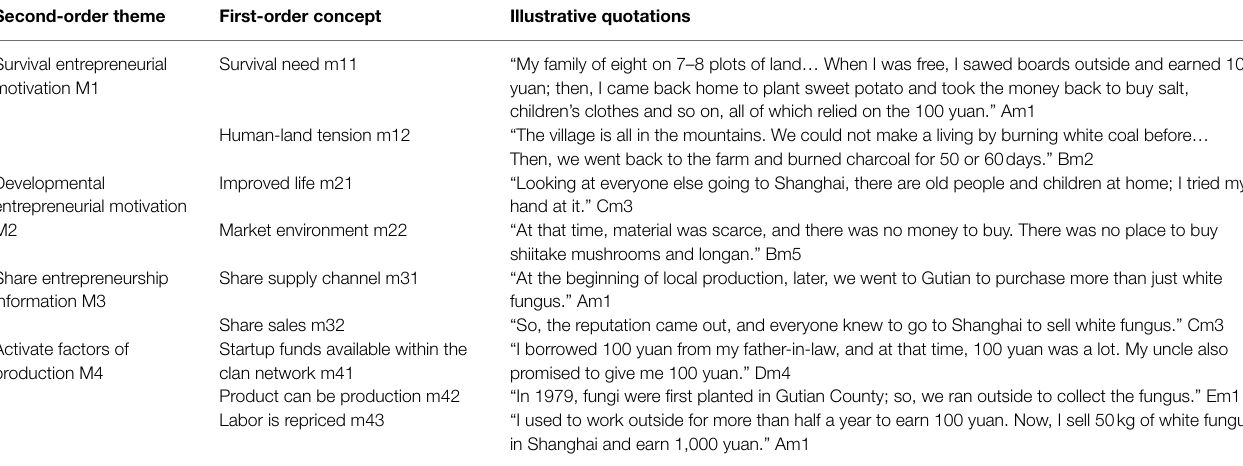
TABLE 3 | Illustrative quotations of first-order concepts in the initial entrepreneurship